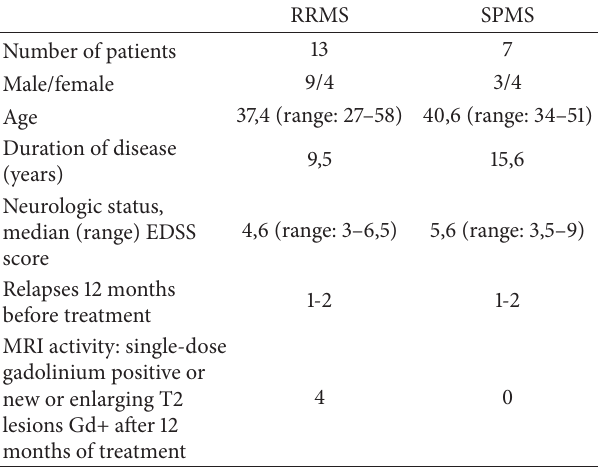
Table 1: Baseline demographic characteristics and disease history of patients with the relapsing-remitting and secondary progressive form of